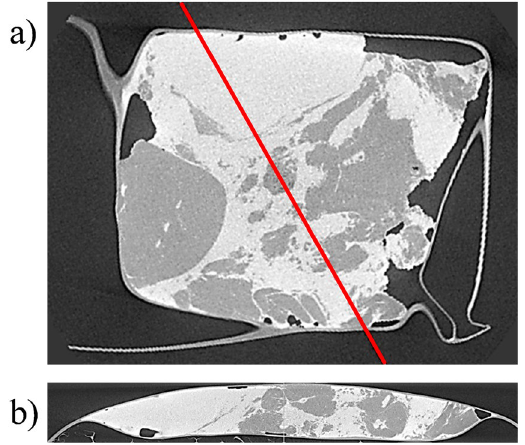
Figure 5. µ CT images of a sample viewed ( a ) in the same orientation as shown in Fig. 2 (right hand column) and ( b ) as an orthogonal slice along the line shown in ( a